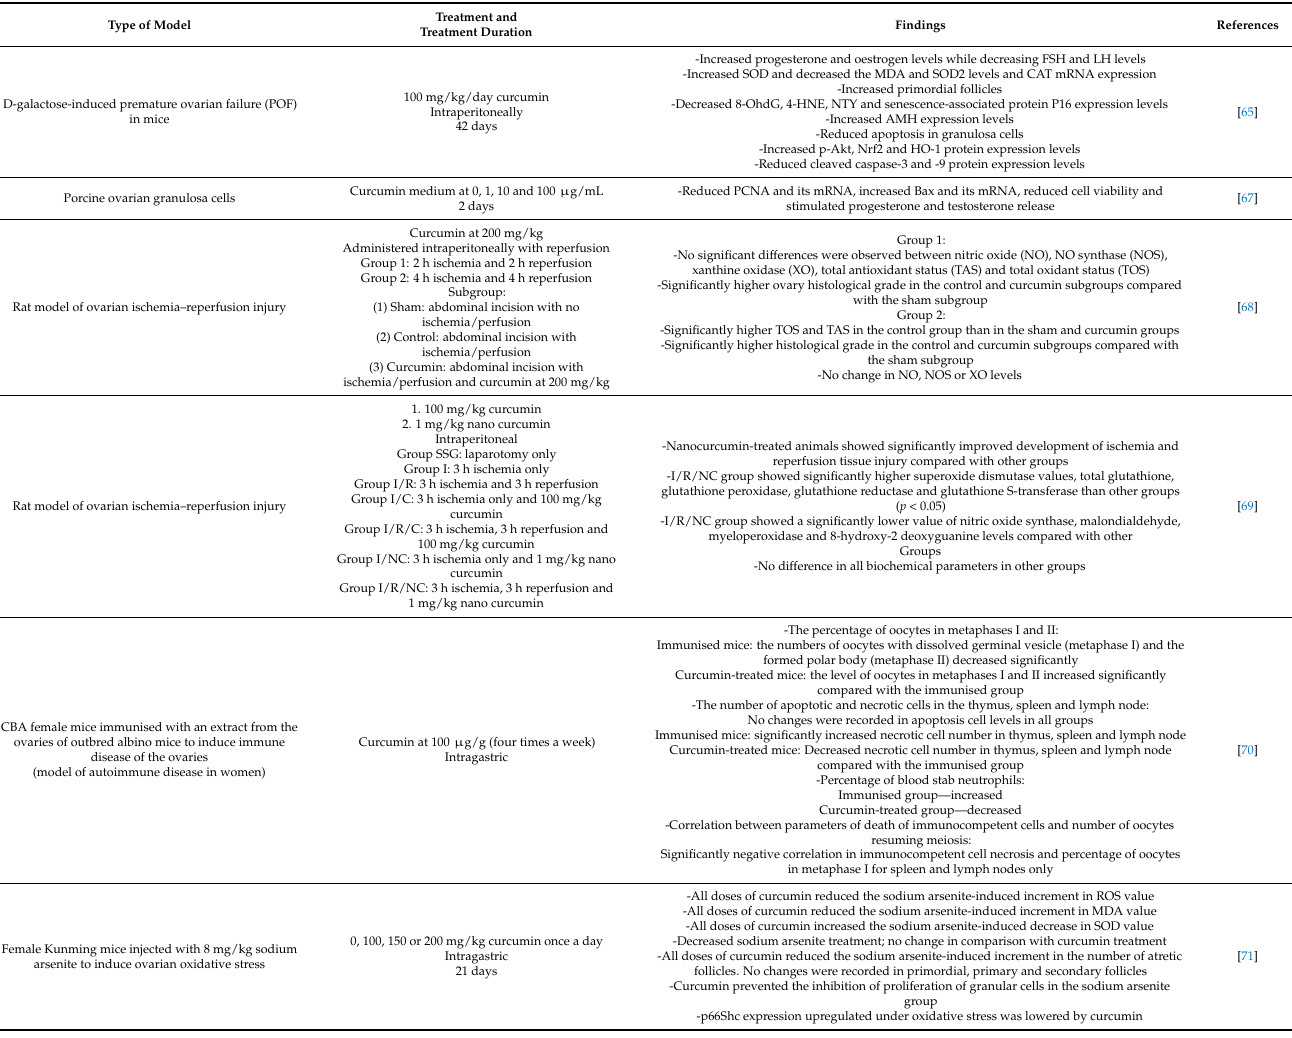
Table 3. Summary of the effects of curcumin on ovarian